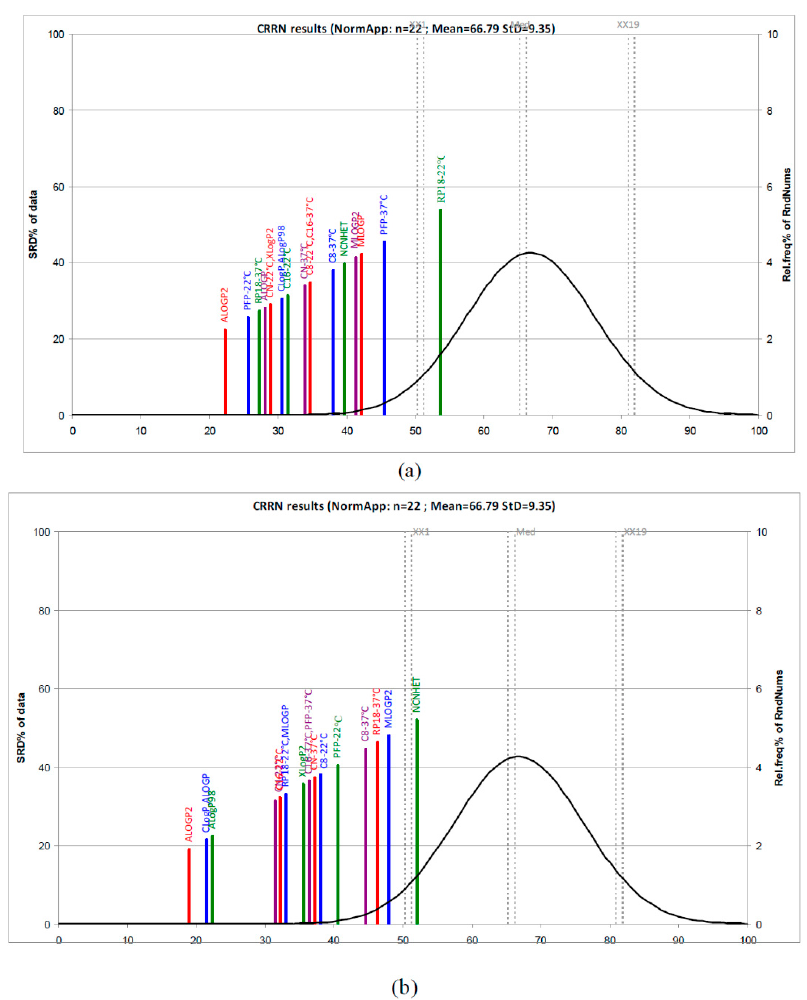
Figure 3. SRD-CRRN ranking of chromatographically estimated lipophilicity indices logkw ( a ) and m logk ( b ), and computationally calculated logP values.